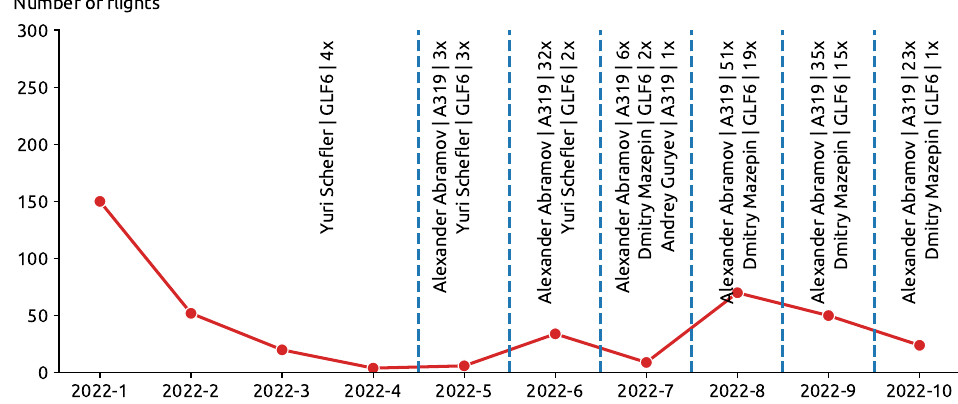
Figure 9. Private jets belonging to Russian owners that are still flying after international sanctions were imposed during 2022.